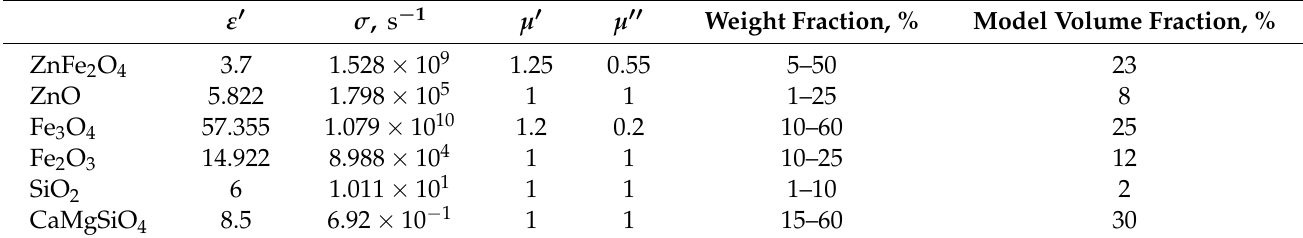
Table 1. Possible content of EAF dust and properties of the components